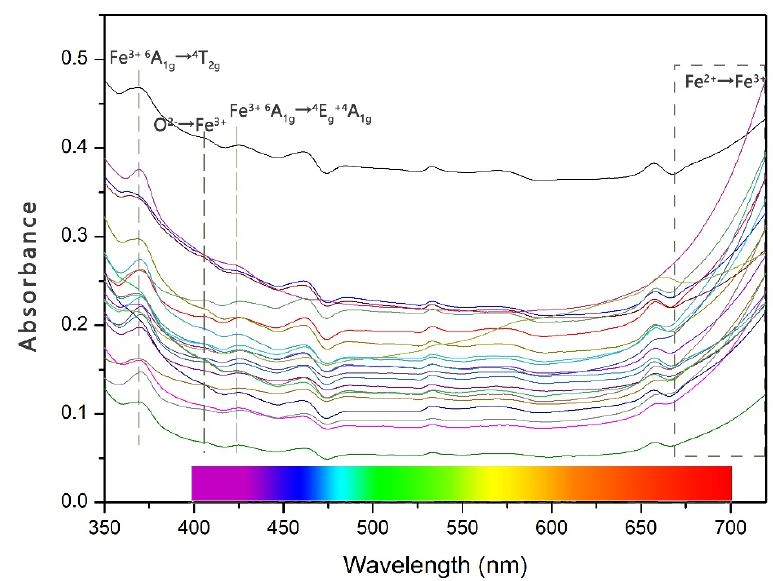
Figure 7. UV–vis spectrum of 23 samples. The different absorption peaks of iron are also plotted.